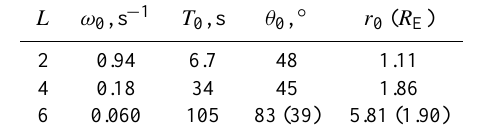
Table 3. List of parameters for L = 2 , 4 , 6 of a compressed-dipole field for φ = π (midnight).